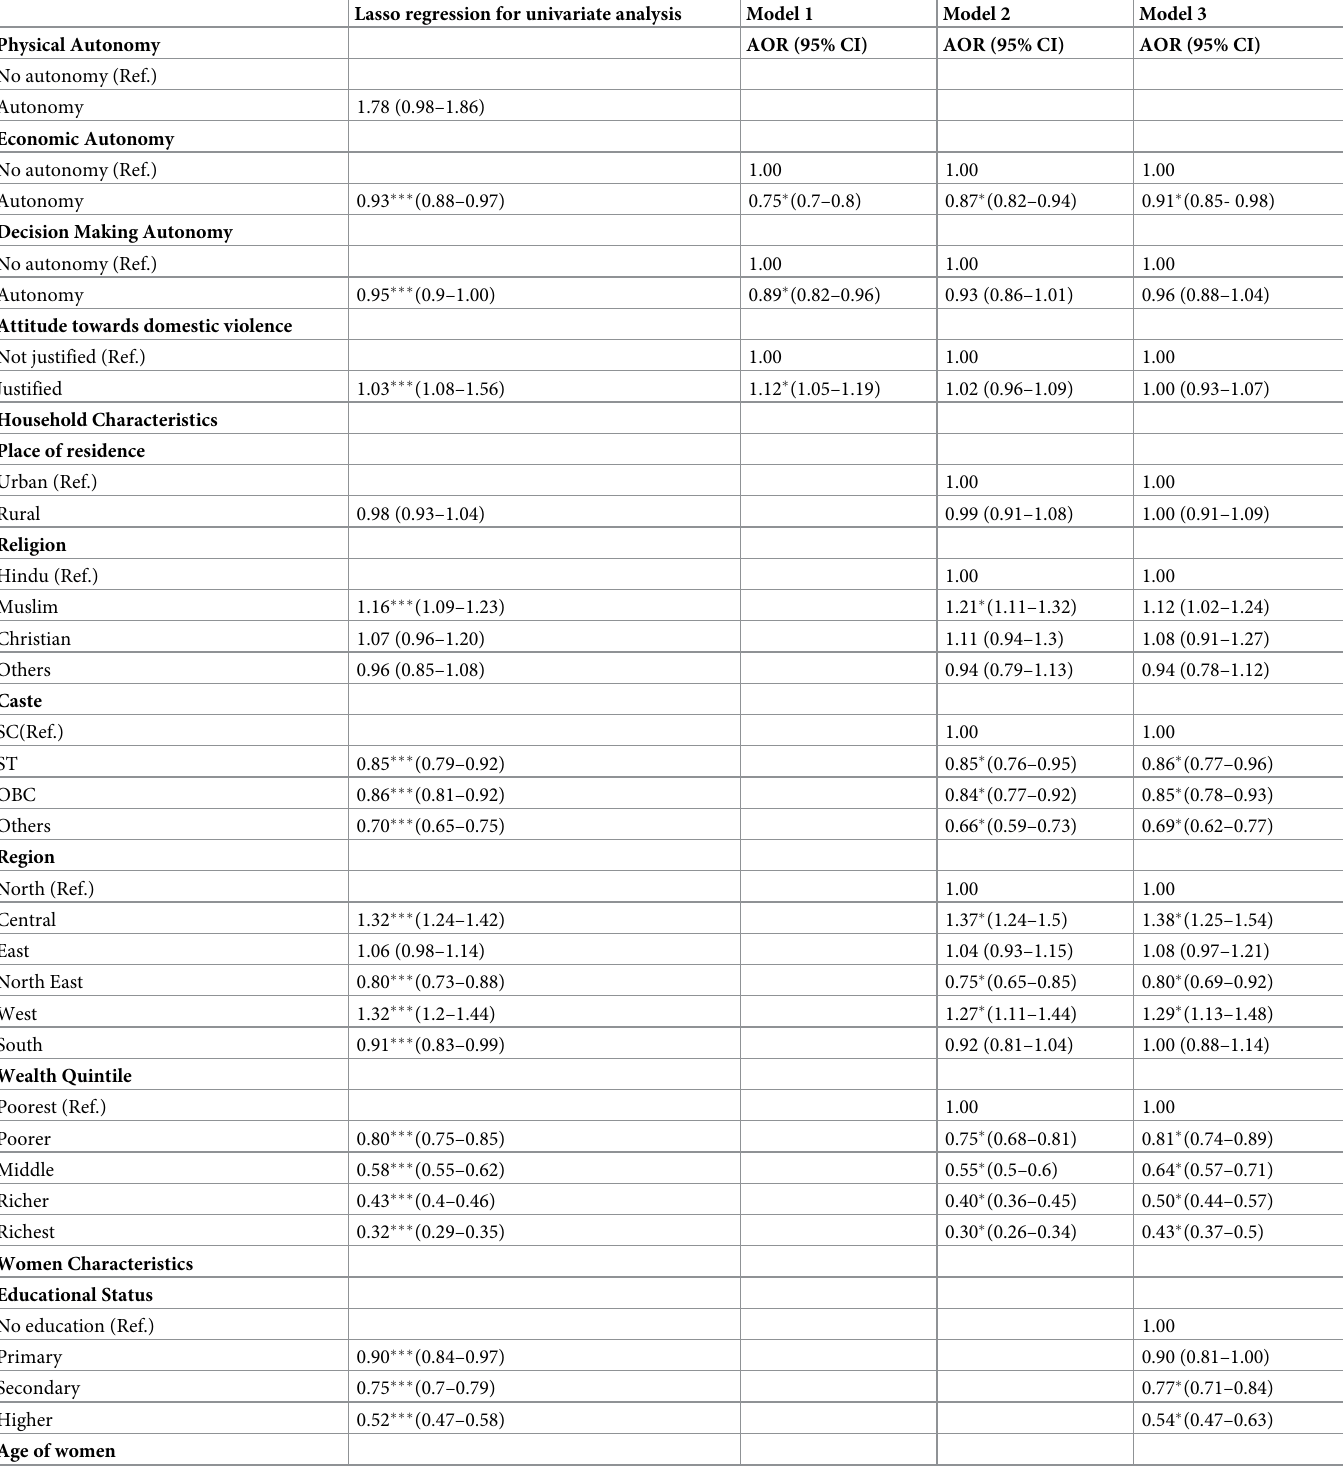
Table 5. Unadjusted and adjusted odds ratios with 95% Confidence interval (CI) for the predictors of stunting in children aged 7–35 months, India, NFHS-4, 2015– 16. Lasso regression for univariate